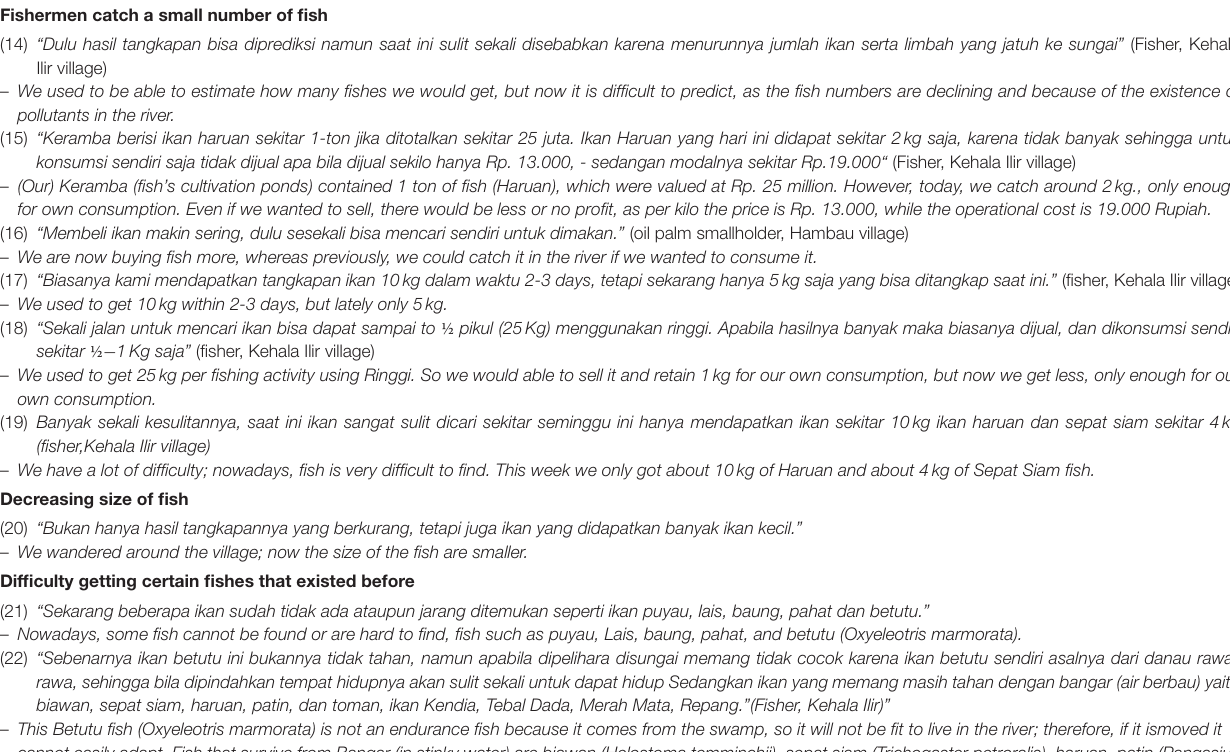
TABLE 5 | Statements of community as the indicators and the impacts of decreasing Ecosystem Services by the community. Fishermen catch a small number of